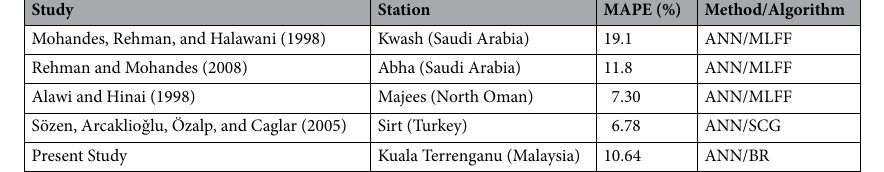
Table 17. Comparison of MAPE with similar